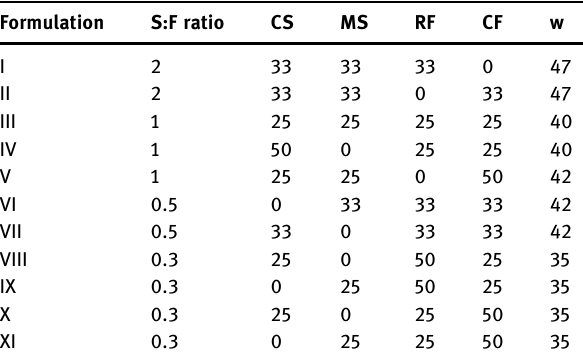
Table 1: Composition of blends ( B ) expressed as g/100 g